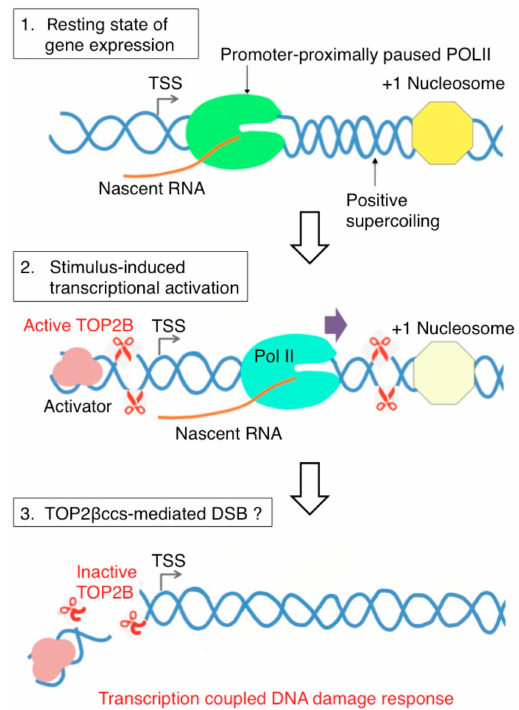
Figure 4. Model of topoisomerase IIB (TOP2B)-mediated DSB and DNA damage response signaling during RNA polymerase II (Pol II) pause release in stimulus-inducible protein-coding genes in humans. Top in the uninduced state of transcription, Pol II is paused between + 25 and + 100 from the transcription start site. The pausing is attributed to di ff erent elements including pausing-stabilizing transcription factors, the + 1 nucleosome, and DNA structure and torsion. Positive supercoiling ahead of Pol II may require the function of TOP2B. Middle, transcription activation induced by various stimuli activates TOP2B to resolve DNA torsion in the promoter and gene body. Bottom, in this process, DSB could be formed from abortive catalysis of TOP2B, which occurs frequently in some genes. This may be responsible for DNA damage response signaling that has been observed in a number of stimulus-inducible genes in humans